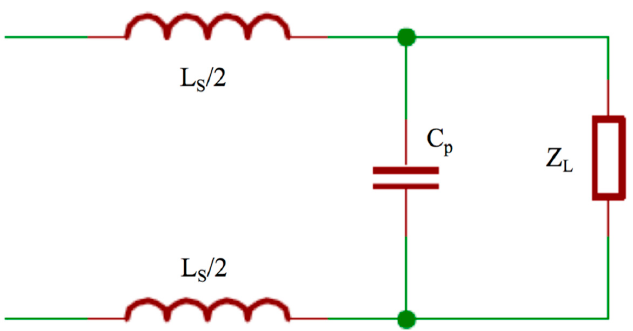
Figure 6. Matching network used to provide the load with higher power.